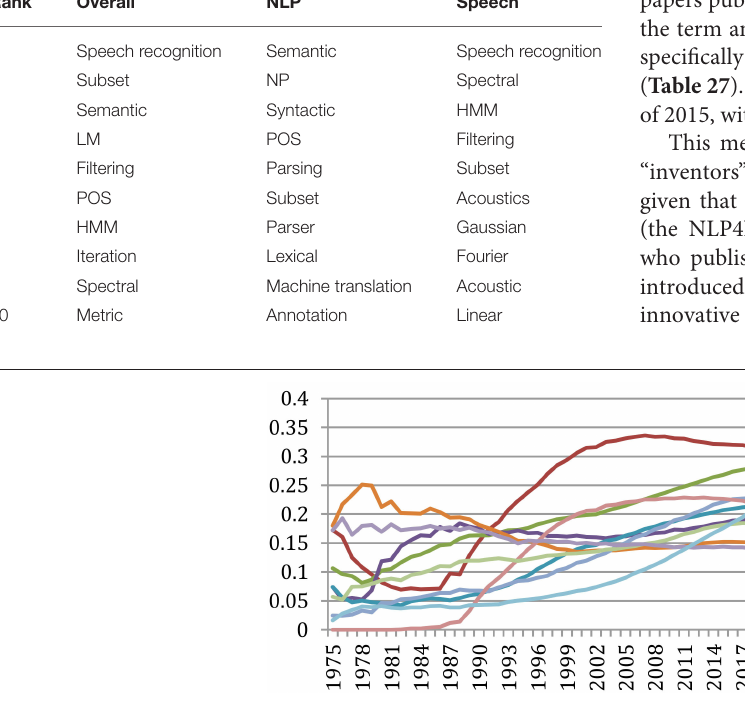
TABLE 26 | Global ranking of the innovation score of the terms overall and separately for speech and NLP up to 2020. Rank